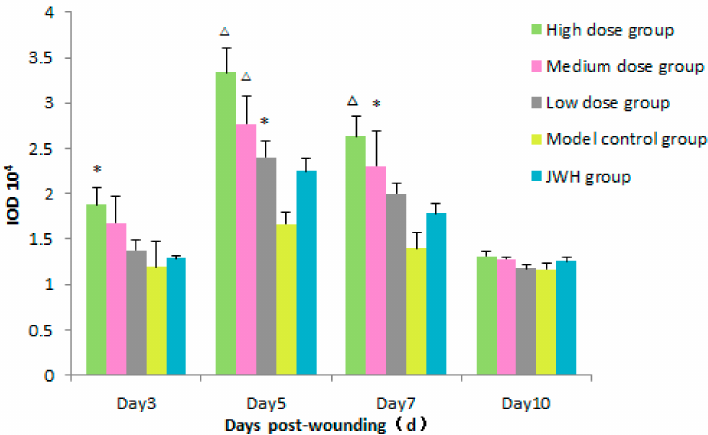
Figure 4. Effects of total flavonoids from B. balsamifera on CD68 levels in wound tissues of rats. Values are expressed as mean ± SD ( n = 6) as compared to control group, * p < 0.05, ∆ p <